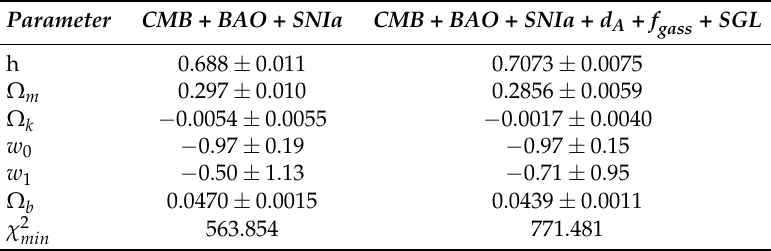
Table 3. Summary of the best fit values for the CPL